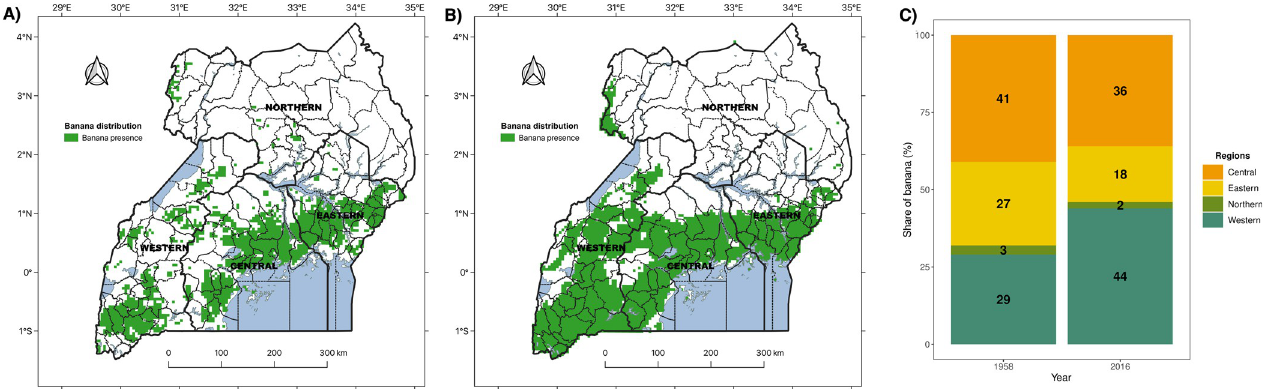
Fig 9. Spatial distribution of banana A) historical banana distribution (1958); B) latest banana distribution (2016) predicted using ensemble model of RF, GBM and NN trained on the 12 covariates; C) percentage share of banana among administrative regions: Northern, Eastern, Central and Western. The share of banana was computed using counts of pixels with banana in each region divided by the total number of pixels with banana in Uganda.